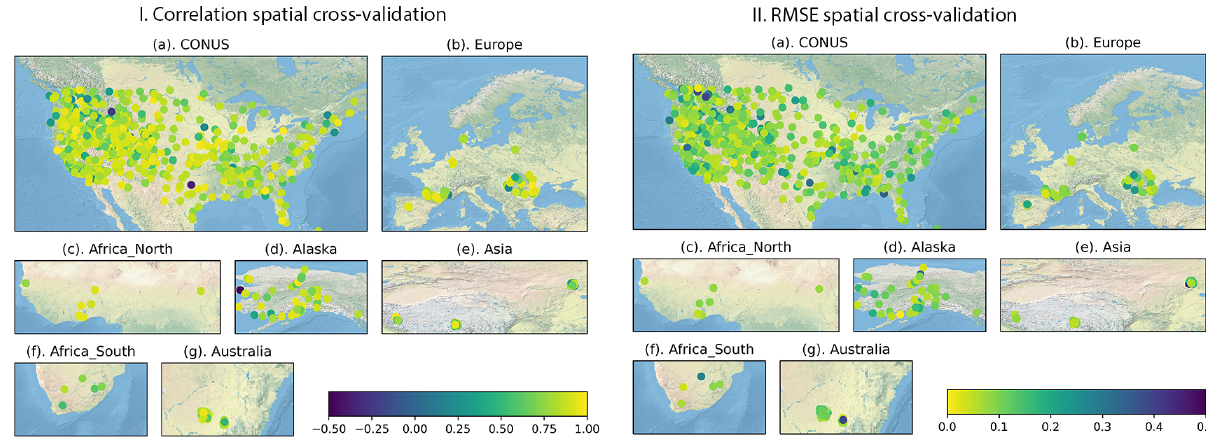
Figure 3. Metric distributions for the multitask model random spatial cross-validation tests. (I) Correlation and (II) RMSE of spatial cross- validation tests for (a) the CONUS, (b) Europe, (c) Africa_North, (d) Alaska, (e) Asia, (f) Africa_South, and (g) Australia. The training and testing periods were both from 1 April 2015 to 31 December 2020. Maps are made with Natural Earth imagery, no permission needed (Natural Earth,